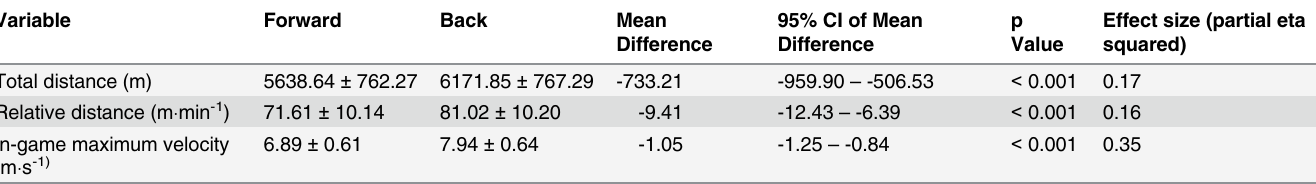
Table 4. Forward vs back running game